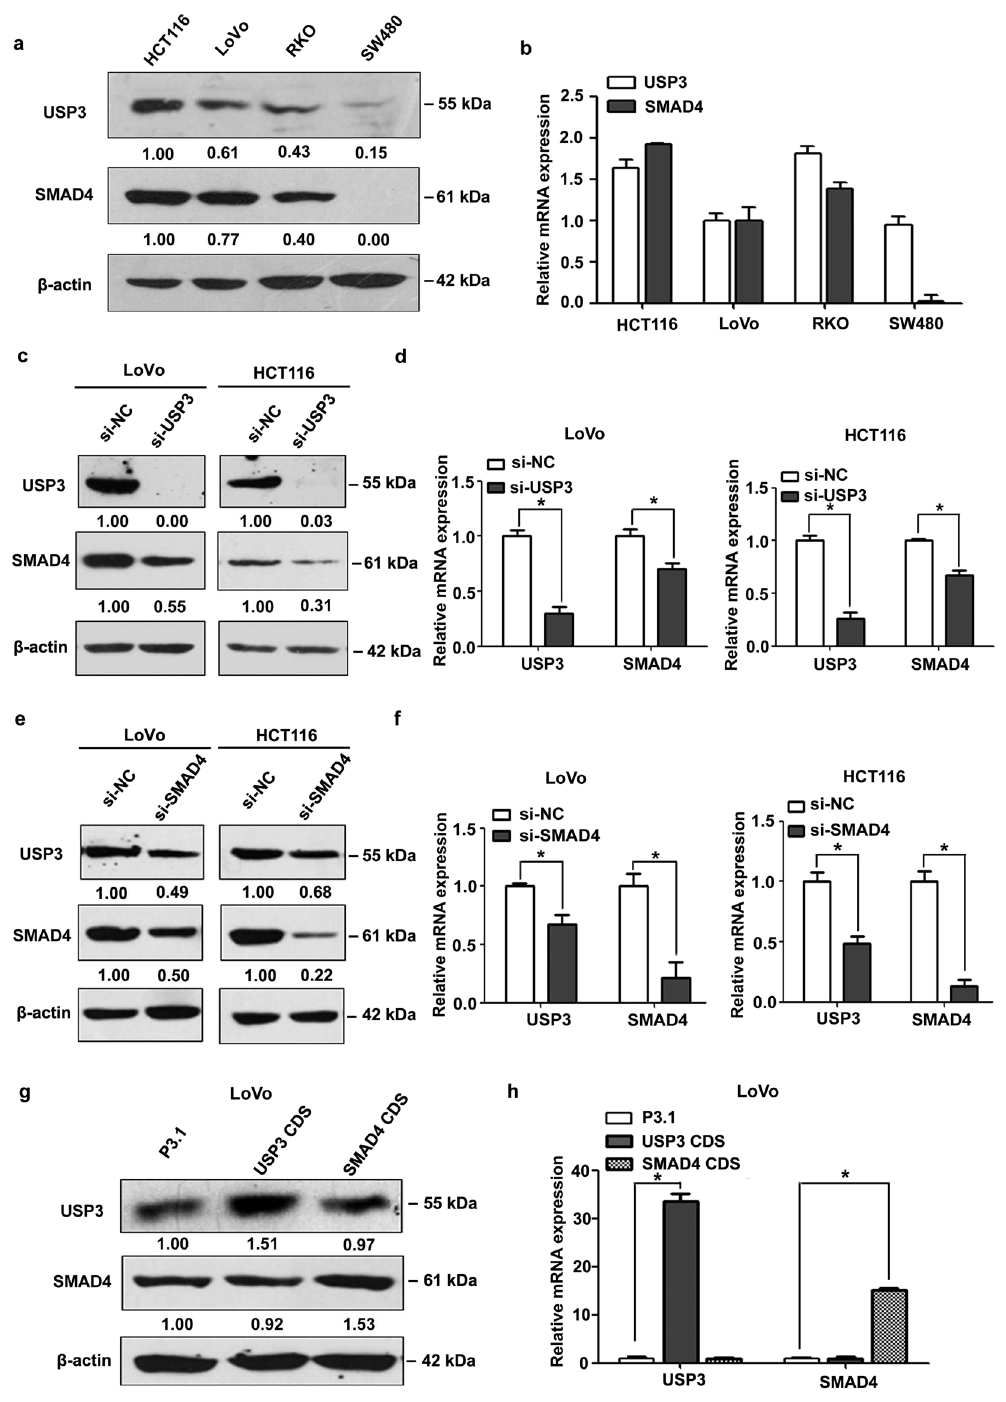
Figure 1. USP3 interacted with SMAD4 at the post-transcriptional level. ( a,b ) Protein and mRNA expression of USP3 and SMAD4 were examined by western blot and qRT-PCR in CRC cells. ( c,e ) USP3 and SMAD4 protein and ( d,f ) mRNA levels were decreased after knockdown of either USP3 or SMAD4 by transfection of siRNA pools in LoVo and HCT116 cells, respectively. ( g,h ) Overexpression of the USP3 or SMAD4 CDS did not affect the other’s expression at both protein and mRNA levels. All values are represented as the mean ± SD (n = 3). Western blot images are cropped; full-length blots are included in Supplementary Figures S7 to S10. The densitometric measurement was performed with each western blot analysis; relative protein expression was normalized to β -actin. * P <